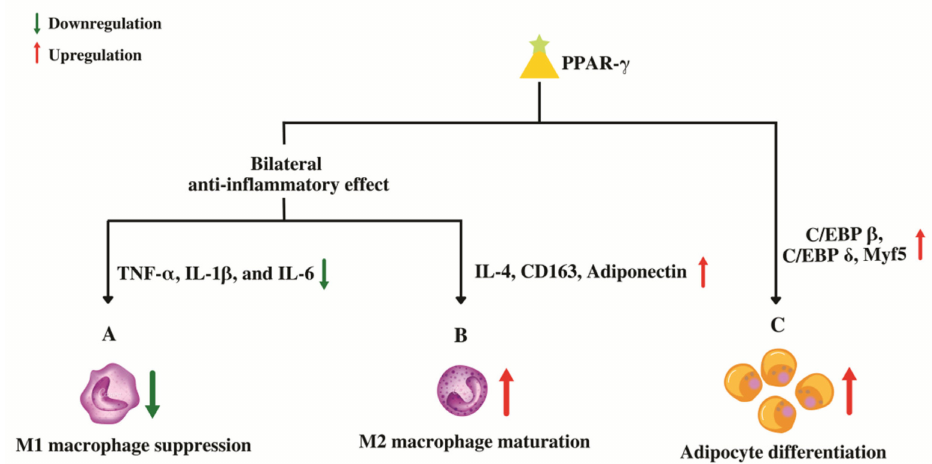
Figure 4. Role of PPAR- γ in macrophage conversion and adipocyte differentiation. ( A ) PPAR- γ suppresses the genes that code for pro-inflammatory molecules, which in-turn prevents the matu- ration of pro-inflammatory wild-type “M1” macrophages. ( B ) PPAR- γ promotes the maturation of anti-inflammatory “M2” macrophages by up-regulating anti-inflammatory genes leading to an overall bilateral anti-inflammatory effect. ( C ) PPAR- γ regulates adipocyte differentiation by upregulating the genes involved in proliferative stage of terminal